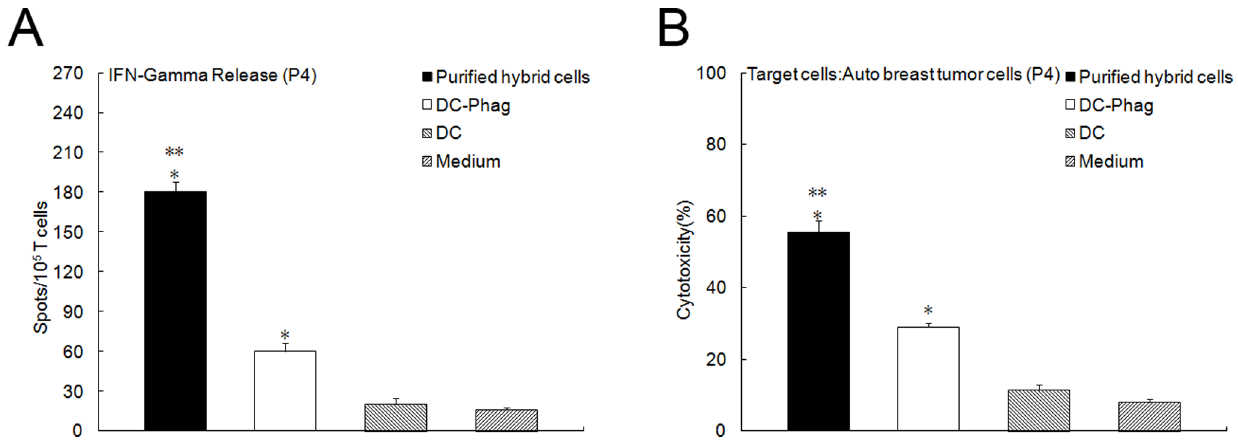
Figure 8. Antitumor immune responses of DCs with phagocytic tumor cells in non-adherent cell fraction. DCs and DCs with phagocytic tumor cells in the non-adherent cells fraction were sorted and antitumor immune response were compared through Ellispot and CTL assay (from patient4). Compared with DCs, DCs with phagocytic tumor cells can stimulate more IFN-Gamma secretion (A, P , 0.05) and much more powerful CTL responses (B, P , 0.05) and the immune responses were not as strong as fusion hybrids (P ,